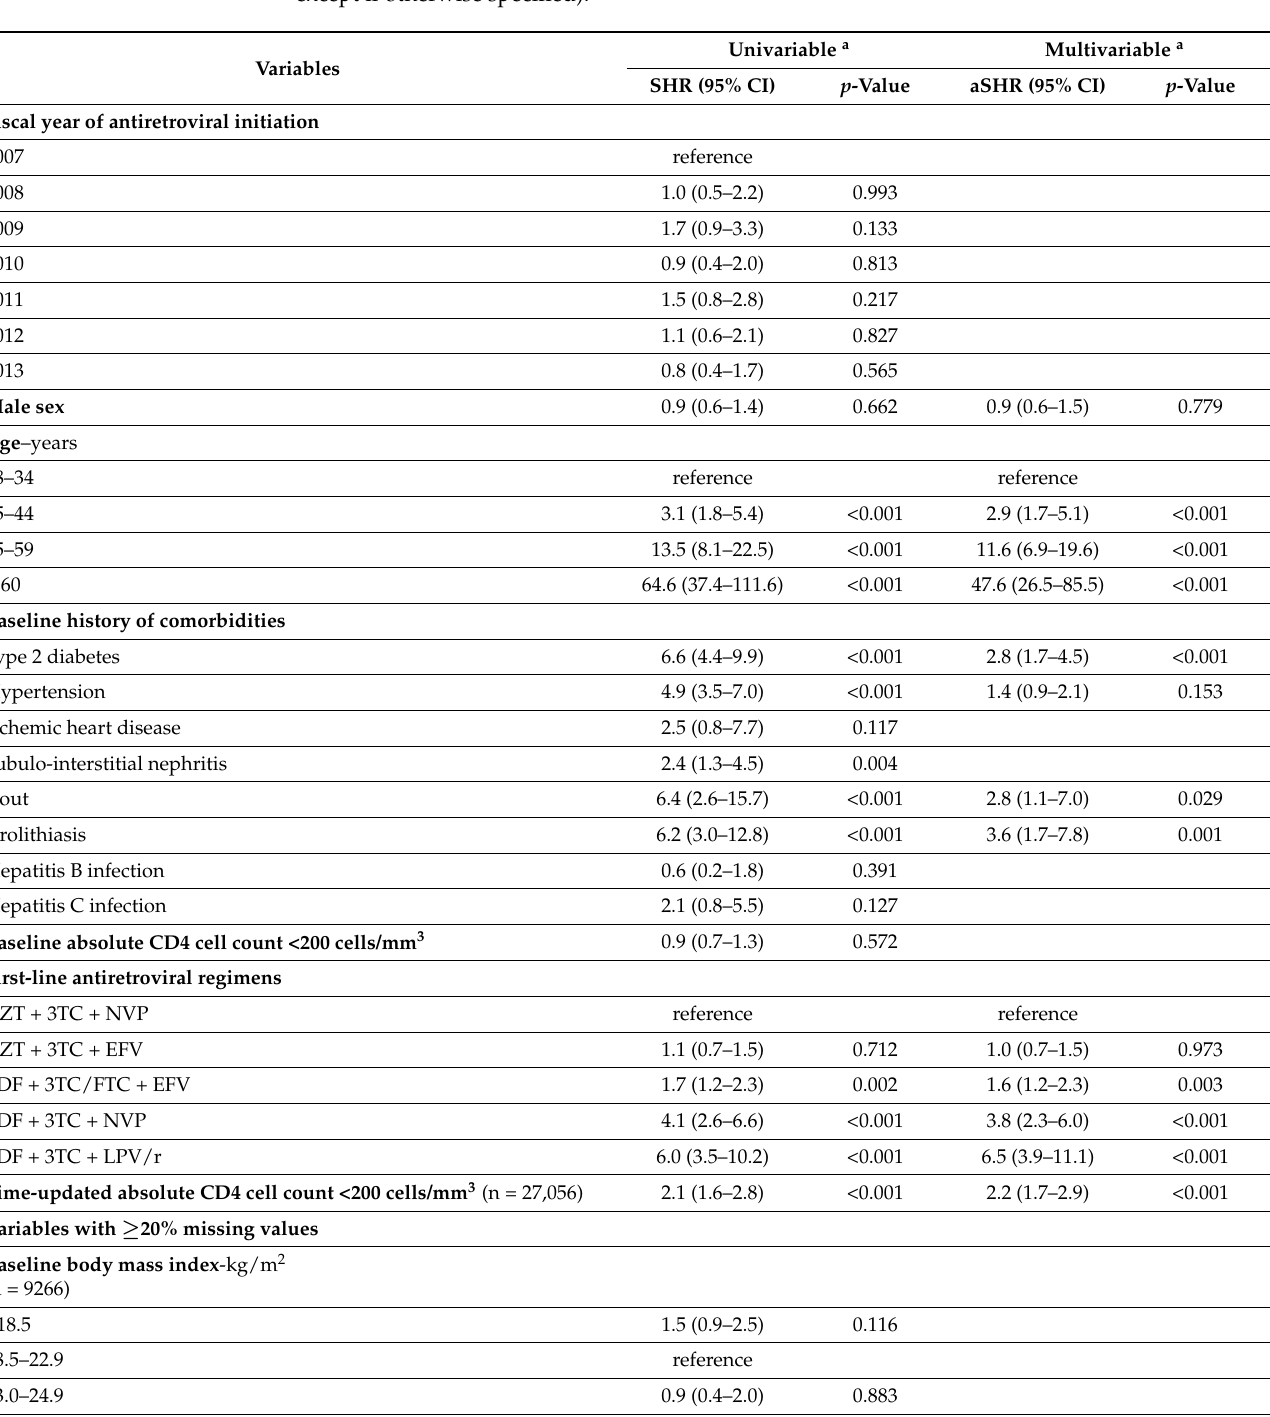
Table 3. Factors associated with the risk of chronic kidney disease in HIV-infected adults who received currently recommended first-line antiretroviral therapy regimens (number of patients 27,313, except if otherwise